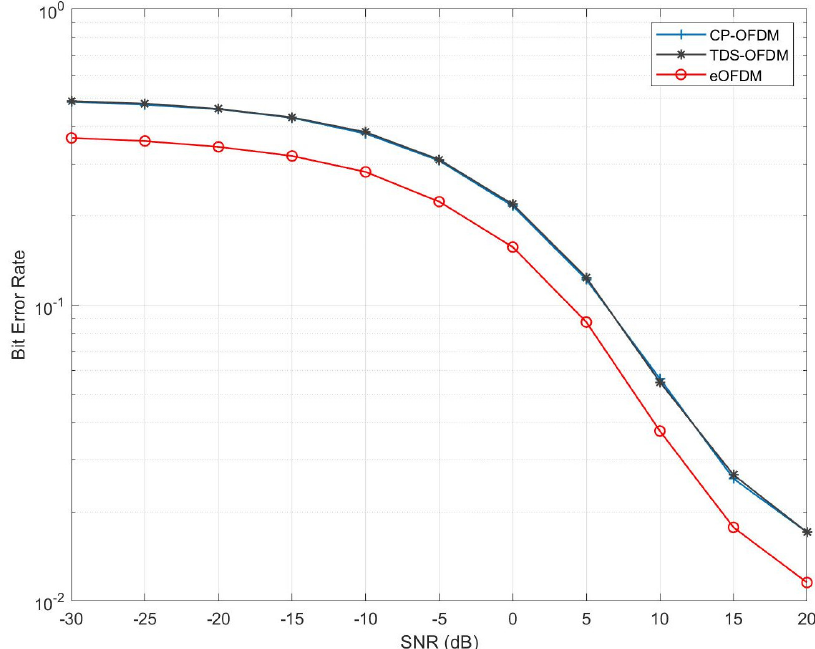
Figure 6. BER comparison of CP-OFDM, TDS-OFDM and eOFDM in multipath Rayleigh fading channel.